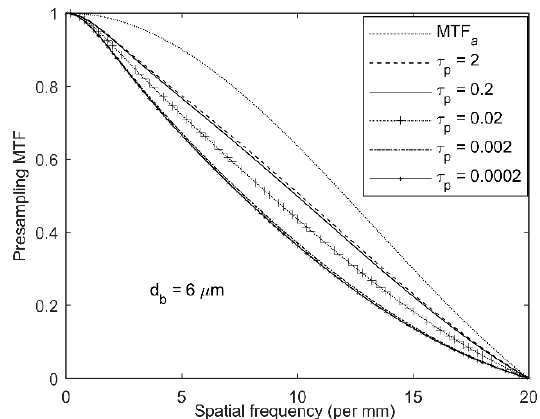
Figure 4. The MTF( f ) as a function of the blocking layer thickness for a-Se mammographic detectors.